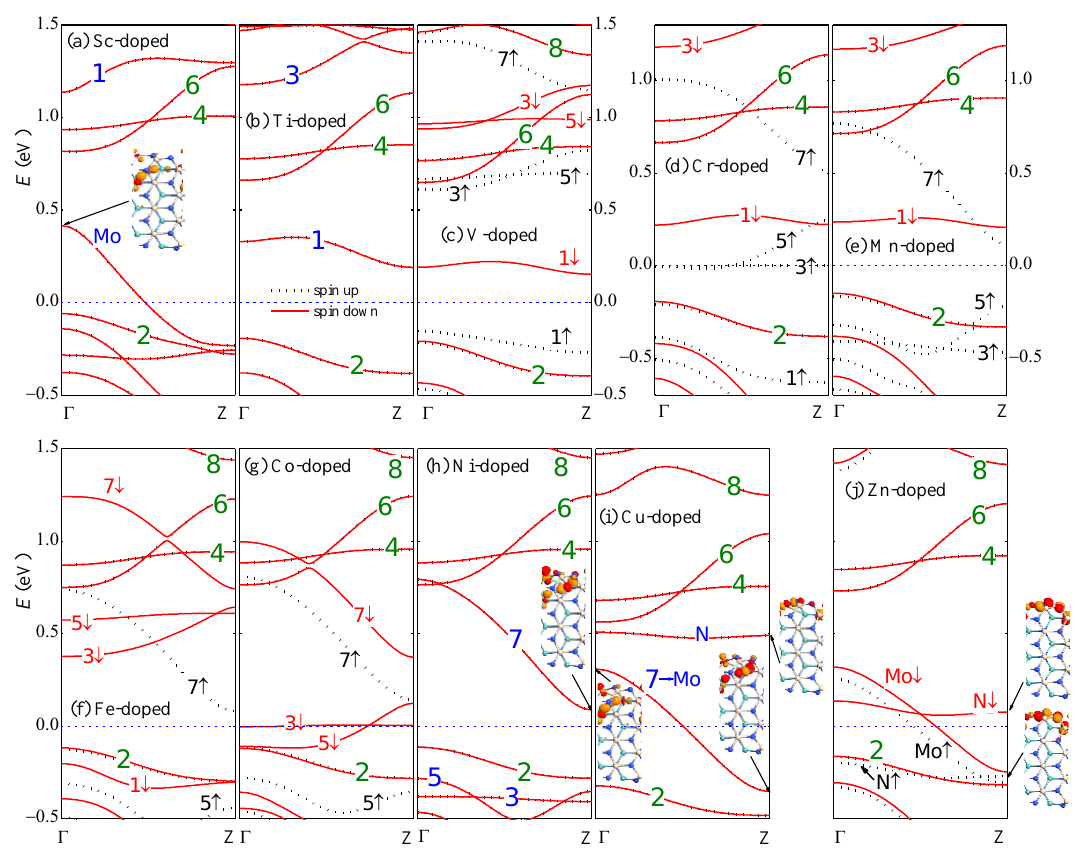
Figure 3. ( a – j ) Band structures of 3d TM (Sc-Zn)-doped aMoSiNNRs. Wave functions of some states in typical bands are shown as insets. The Fermi energy is set to zero.